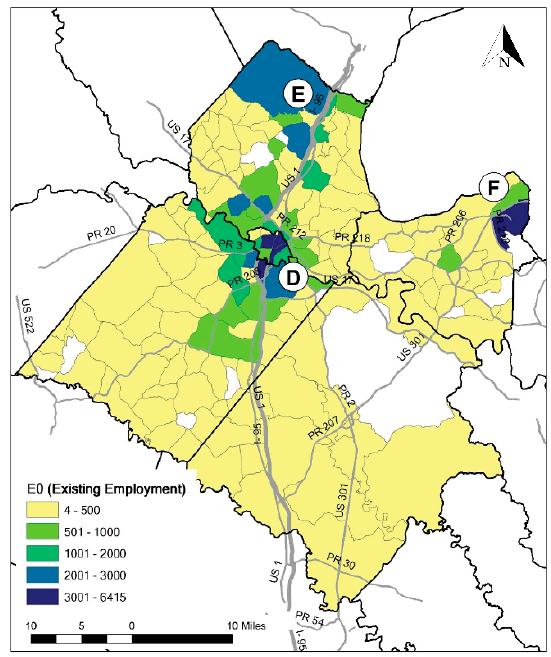
Figure 3. FAMPO Employment in 2000.